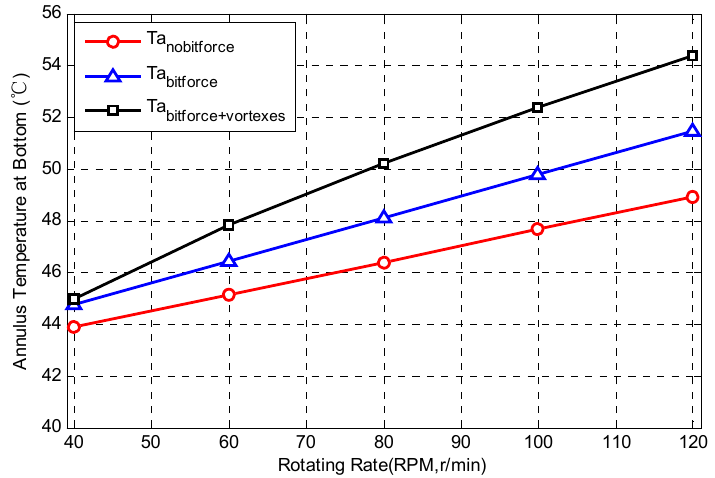
the magnitude of increase gradually became smaller.